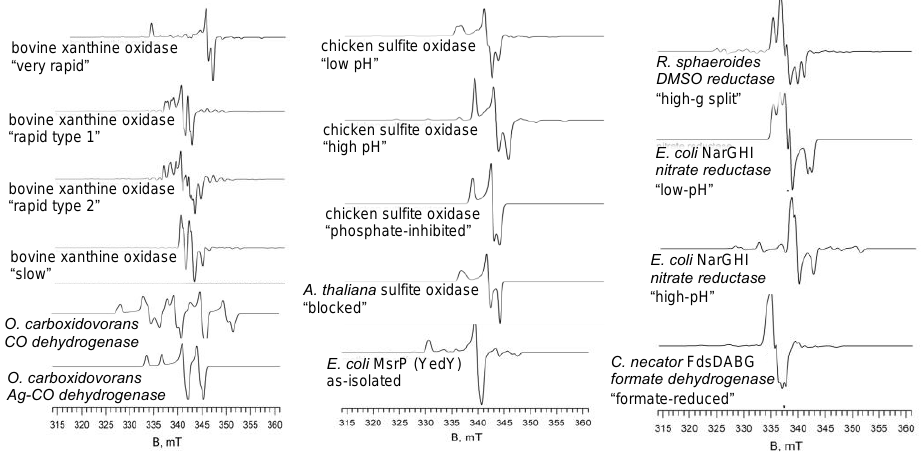
Figure 3. EPR signals seen with various molybdenum-containing enzymes. ( Left ), the “Very Rapid”, “Rapid Type 1”, “Rapid Type 2” and “Slow” signals of xanthine oxidase, the Mo/Cu center of CO dehydrogenase and its Ag-substituted form. ( Center ), the “Low-pH”, “High-pH” and “Phosphate- inhibited” forms of chicken sulfite oxidase, the “Blocked” signal seen with the A. thaliana enzyme and the EPR signal seen with as-isolated MsrP. ( Right ), the “high-g Split” signal seen with R. sphaeroides DMSO reductase, low- and high-pH forms of E. coli nitrate reductase and C. necator formate dehydrogenase. All spectra are simulations at 9 GHz using published g-values and hyperfine couplings (see text).